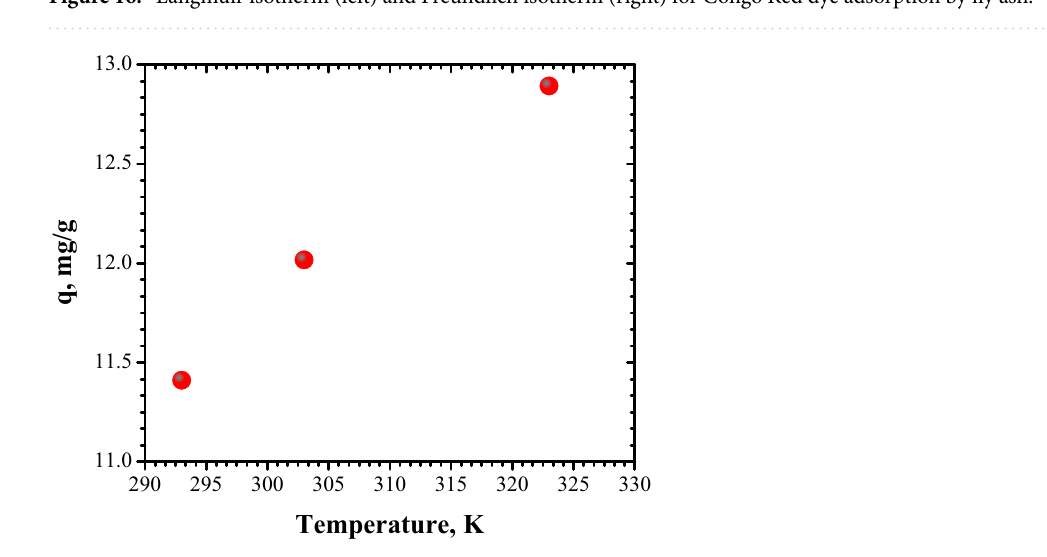
Figure 16. Langmuir isotherm (left) and Freundlich isotherm (right) for Congo Red dye adsorption by fly ash.